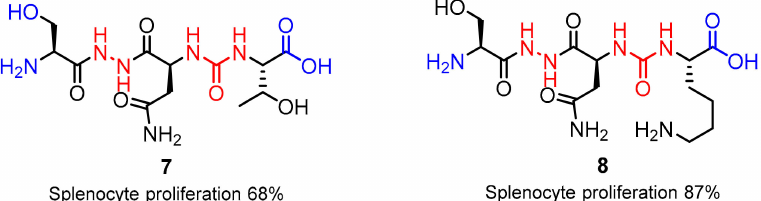
Figure 5. Representative structures of the Aurigene peptidomimetics 7 and 8 . The SAR-a ff ected parts are marked in blue.